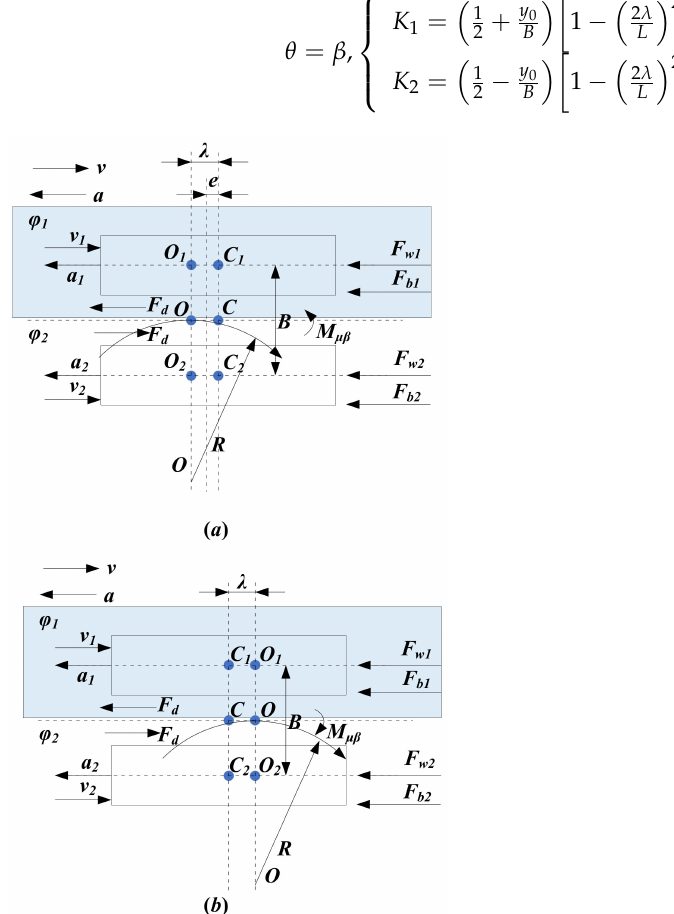
Figure 17. Analysis of the force of the tracks on both sides when braking on the lateral split road surface: ( a ) the upper side locks first (steering down the slope); ( b ) the lower side locks first (steering up the